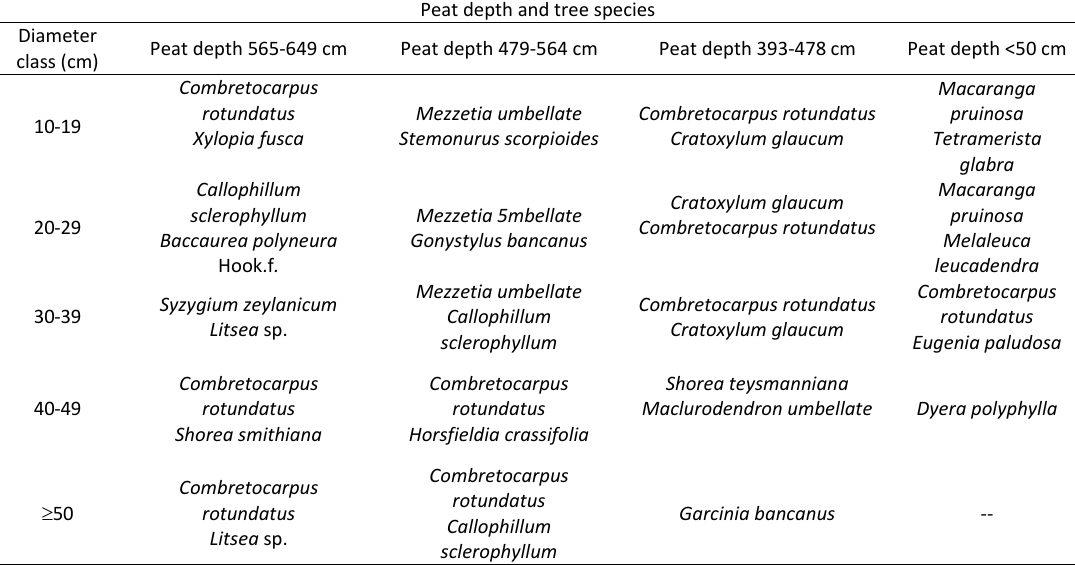
Table 5: Dominant trees by diameter at the research sites Peat depth and tree species